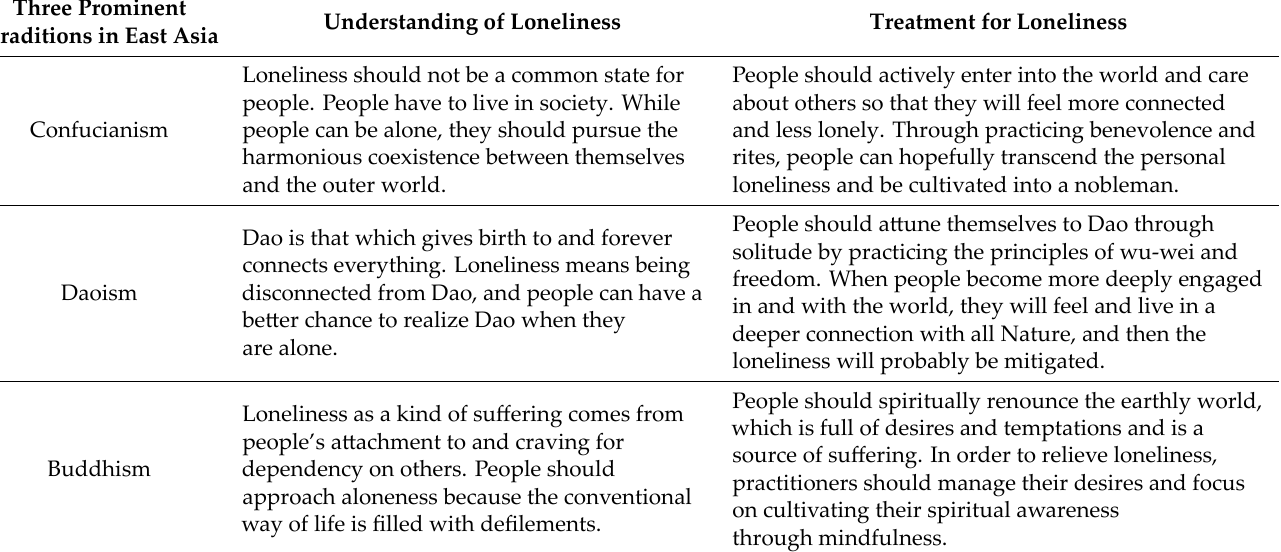
Table 1. Different understanding and treatment of loneliness by the three